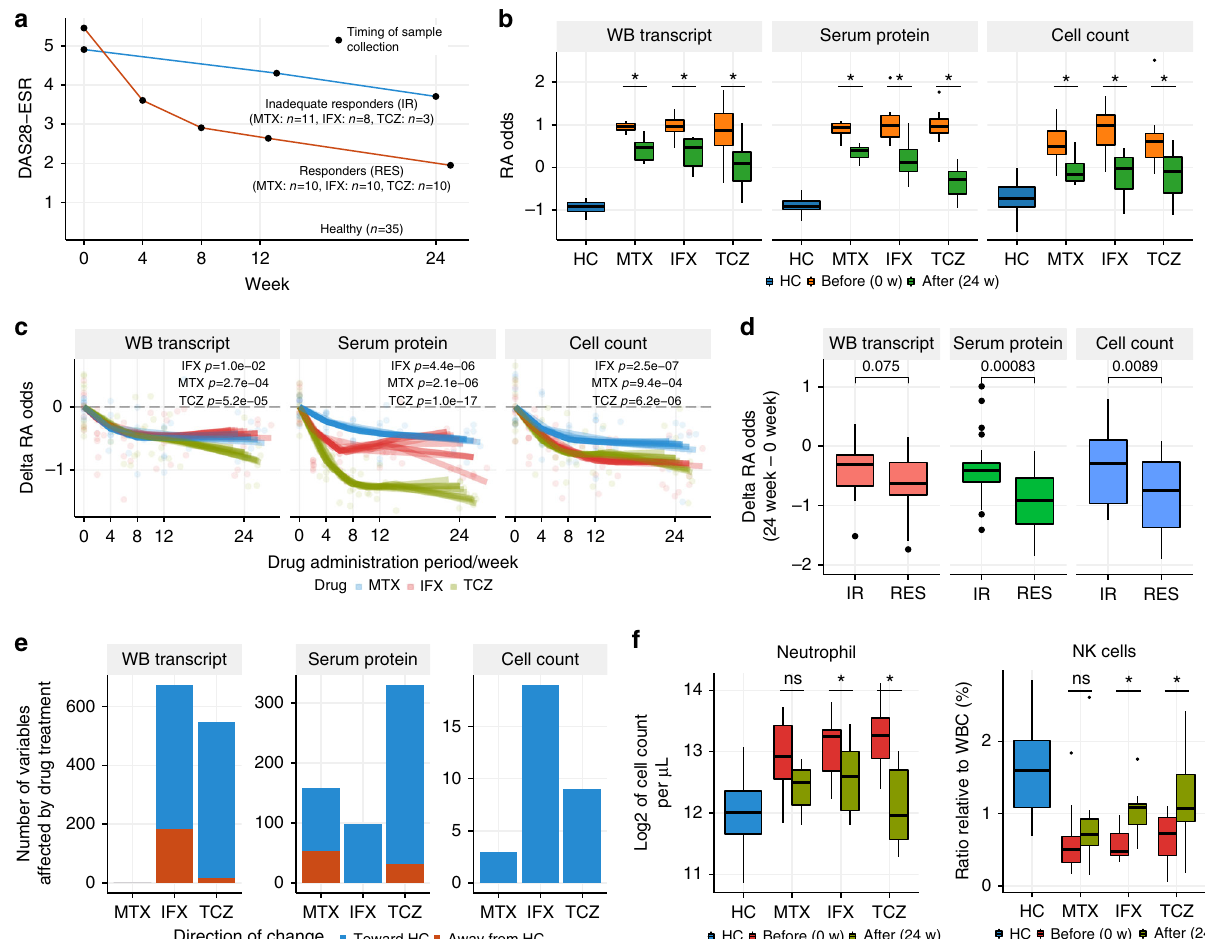
Fig. 2 Evaluation of the effects of drug treatments on molecular pro fi les. a Sample collection design of the drug response cohort. Responders and inadequate responders to the drug treatments were de fi ned based on EULAR response criteria. Patients who displayed a good response via the criteria at 24 weeks after the fi rst drug administration were classi fi ed as responders; others were classi fi ed as inadequate responders. The average DAS28-ESR and sampling timing for each group are shown. b RA probability changes induced by the treatments. RA probability was transformed to log-odds, and the log- odds at week 0 were compared with those at week 24 using the paired t -test (* p < 0.05) for each treatment arm ( n = 10 for each drug). c The temporal change in log-odds for being RA during the treatments. The temporal effects of RA odds ( n = 10 for each drug) were modeled with B-spline smoothing, in which an individual was treated as a random effect. d Correlation between the model-based assessments of drug effects and the clinical de fi nition of drug response. The treatment effects on RA odds were compared between responders ( n = 30) and inadequate responders ( n = 22) by Welch's t -test. e The number of variables affected by drug treatments (24 vs 0 weeks). Treatment effect was tested for each drug ( n = 10) via limma by taking into account the paired samples. RIN value was included in the regression model for testing transcripts. The criterion for signi fi cance was set at a p value <0.05 and FDR <0.05. f Neutrophil and NK cell counts before and after treatment. The asterisk represents a p value <0.05 and FDR <0.05. The upper, center, and lower line of the boxplot indicates 75%, 50%, and 25% quantile, respectively. The upper and lower whisker of the boxplot indicates 75% quantile + 1.5 * interquartile range (IQR) and 25% quantile − 1.5 *